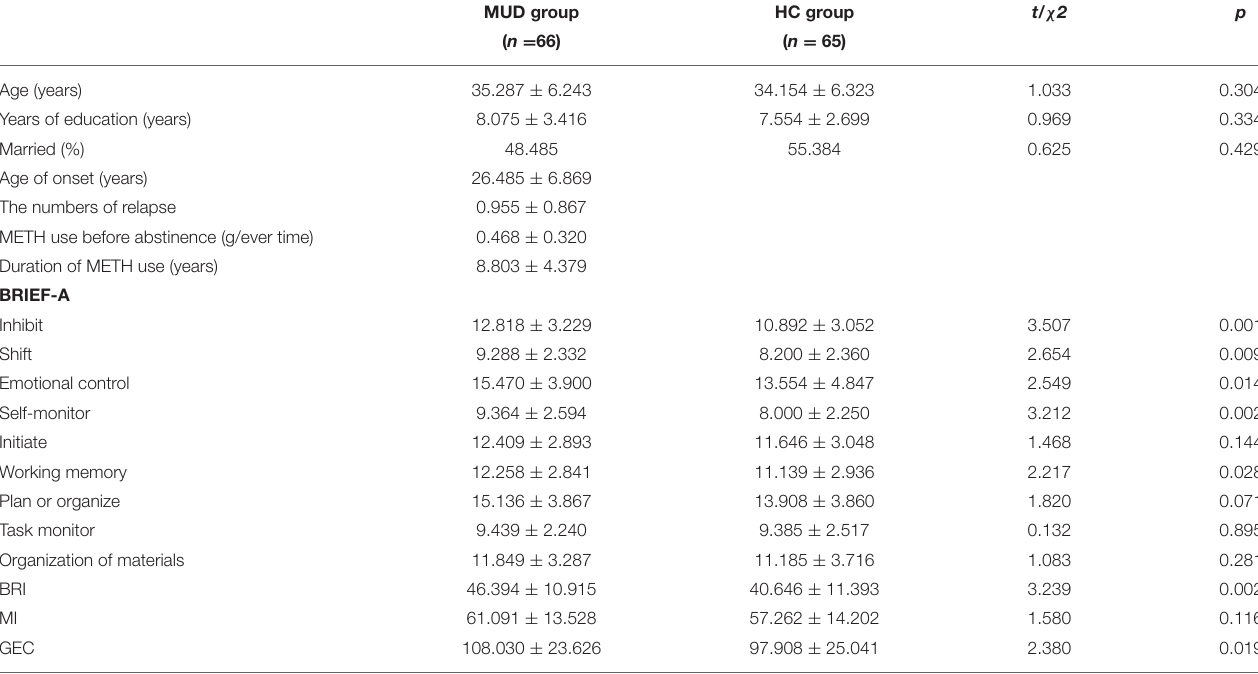
TABLE 1 | Demographics, drug use history, and BRIEF-A data in MUD and healthy control groups.